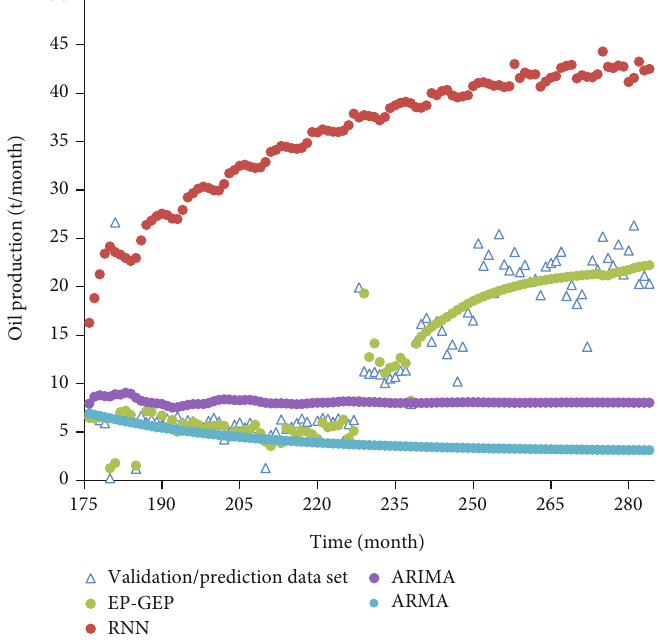
Figure 7: Comparison chart of prediction results of di ff erent time series analysis series training. The experimental parameters are listed in Table 1. Groups 176 – 284 were used as veri fi cation and pre- diction data sets.